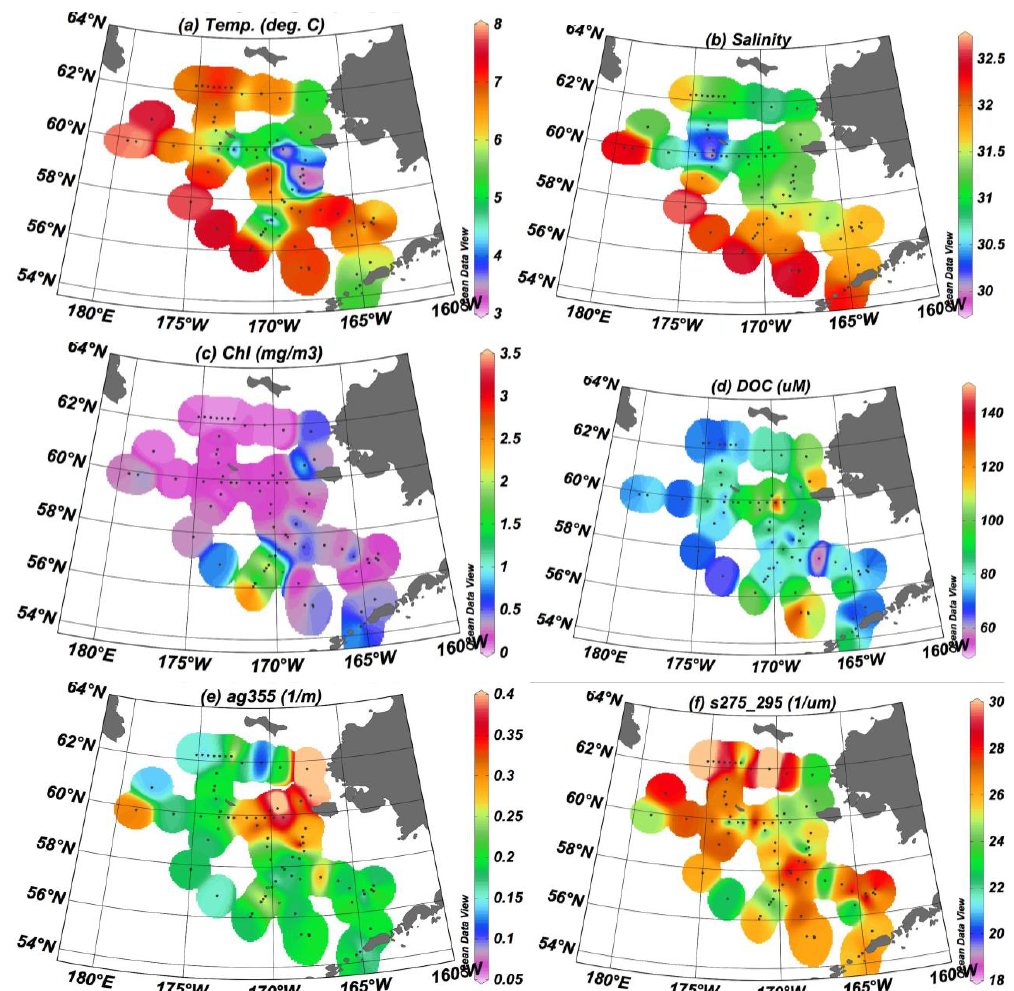
Figure 3. Spatial distributions of (a) temperature, (b) salinity, (c) Chl, (d) DOC, (e) a g 355, and (f) S or S 275 − 295 at surface ( ∼ 2m depth) over the study